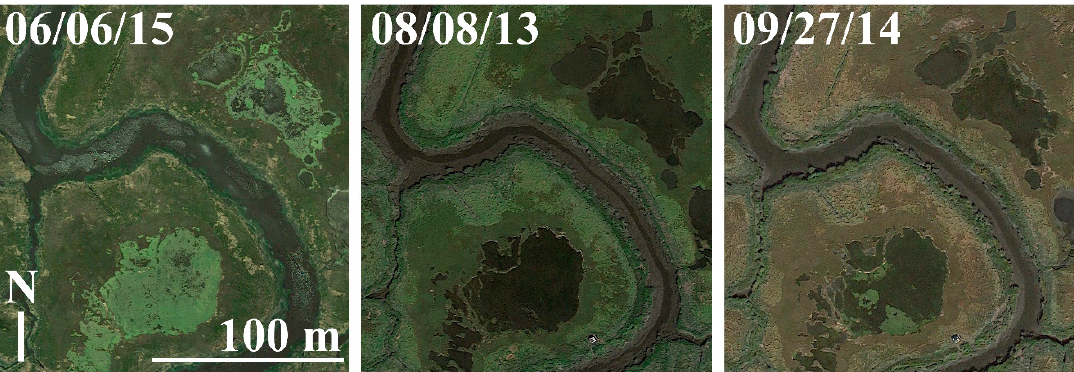
Figure 20. Aerial imagery showing the variable extent of algae in saltmarsh pannes. The images are arranged in order of month of year from left to right. Imagery source: Google.